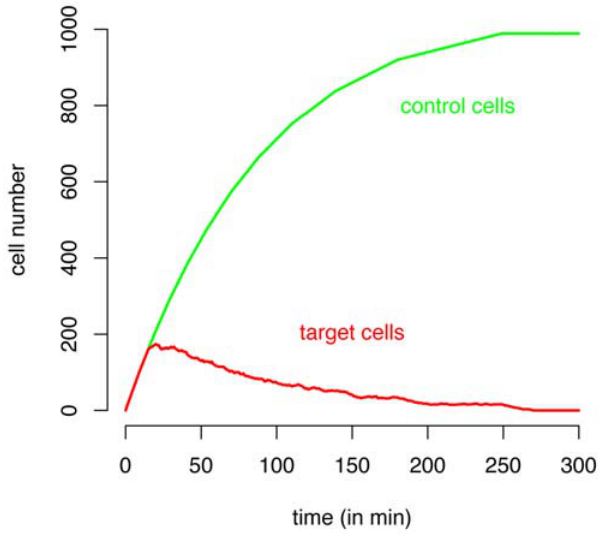
Figure 5. Cell density dynamics for one simulation. The development of the number of target and control cells is shown for a